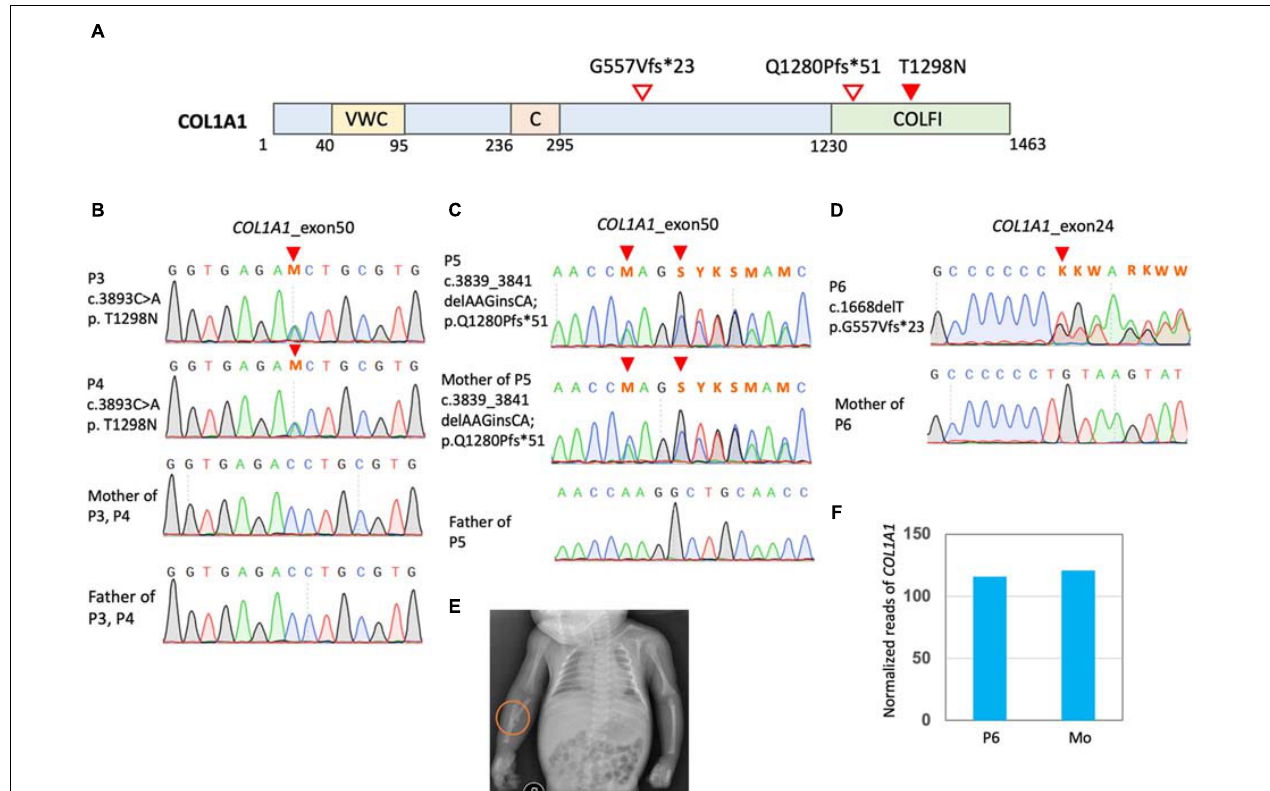
FIGURE 3 | Mutation in COL1A1 in the OI patients. (A) Positions of COL1A1 (NP_000079.2) variants. VWC, von Willebrand factor type C domain; C, Collagen triple helix repeat (20 copies); COLFI, Fibrillar collagen C-terminal domain. (B–D) Sanger sequencing confirmed COL1A1 mutation. (E) P3 presented a greenstick fracture in the mid-shaft of the right radius and ulna. (F) Read counts of COL1A1 in RNA sequencing of PBMCs of OI patients P6 carrying COL1A1 c.1668delT. Mo, mother of